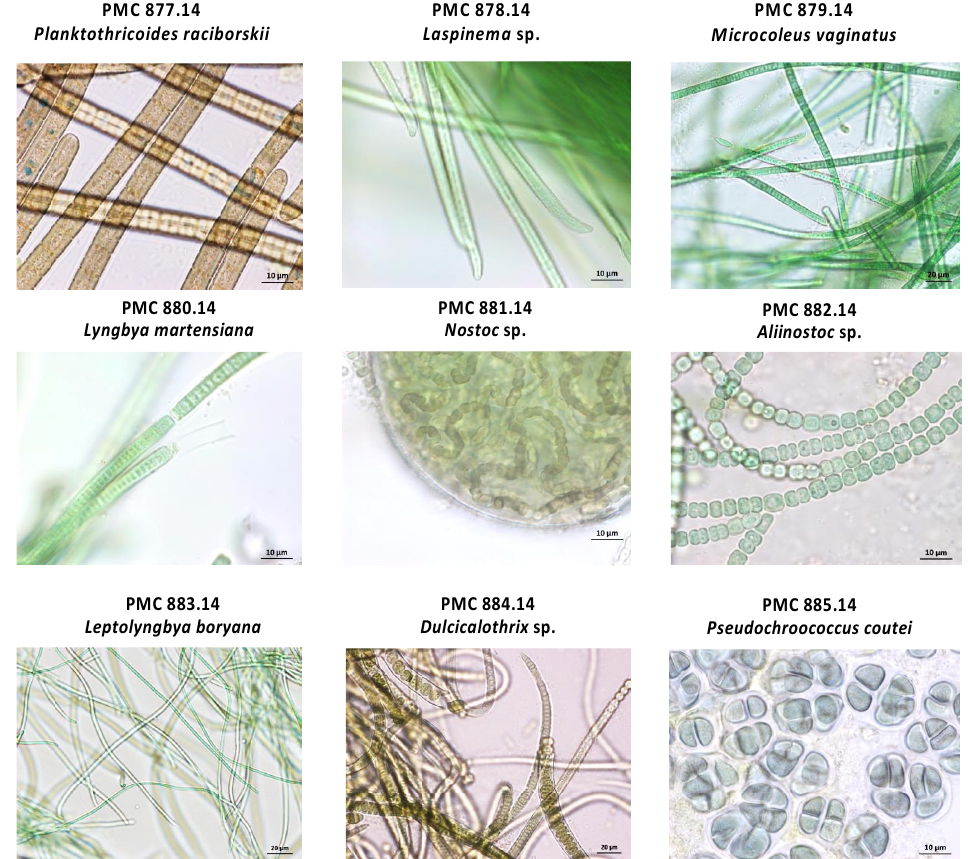
Figure 2. Representative microscopic view of the nine strains from the thermal mud of the Thermes of Balaruc-Les-Bains.